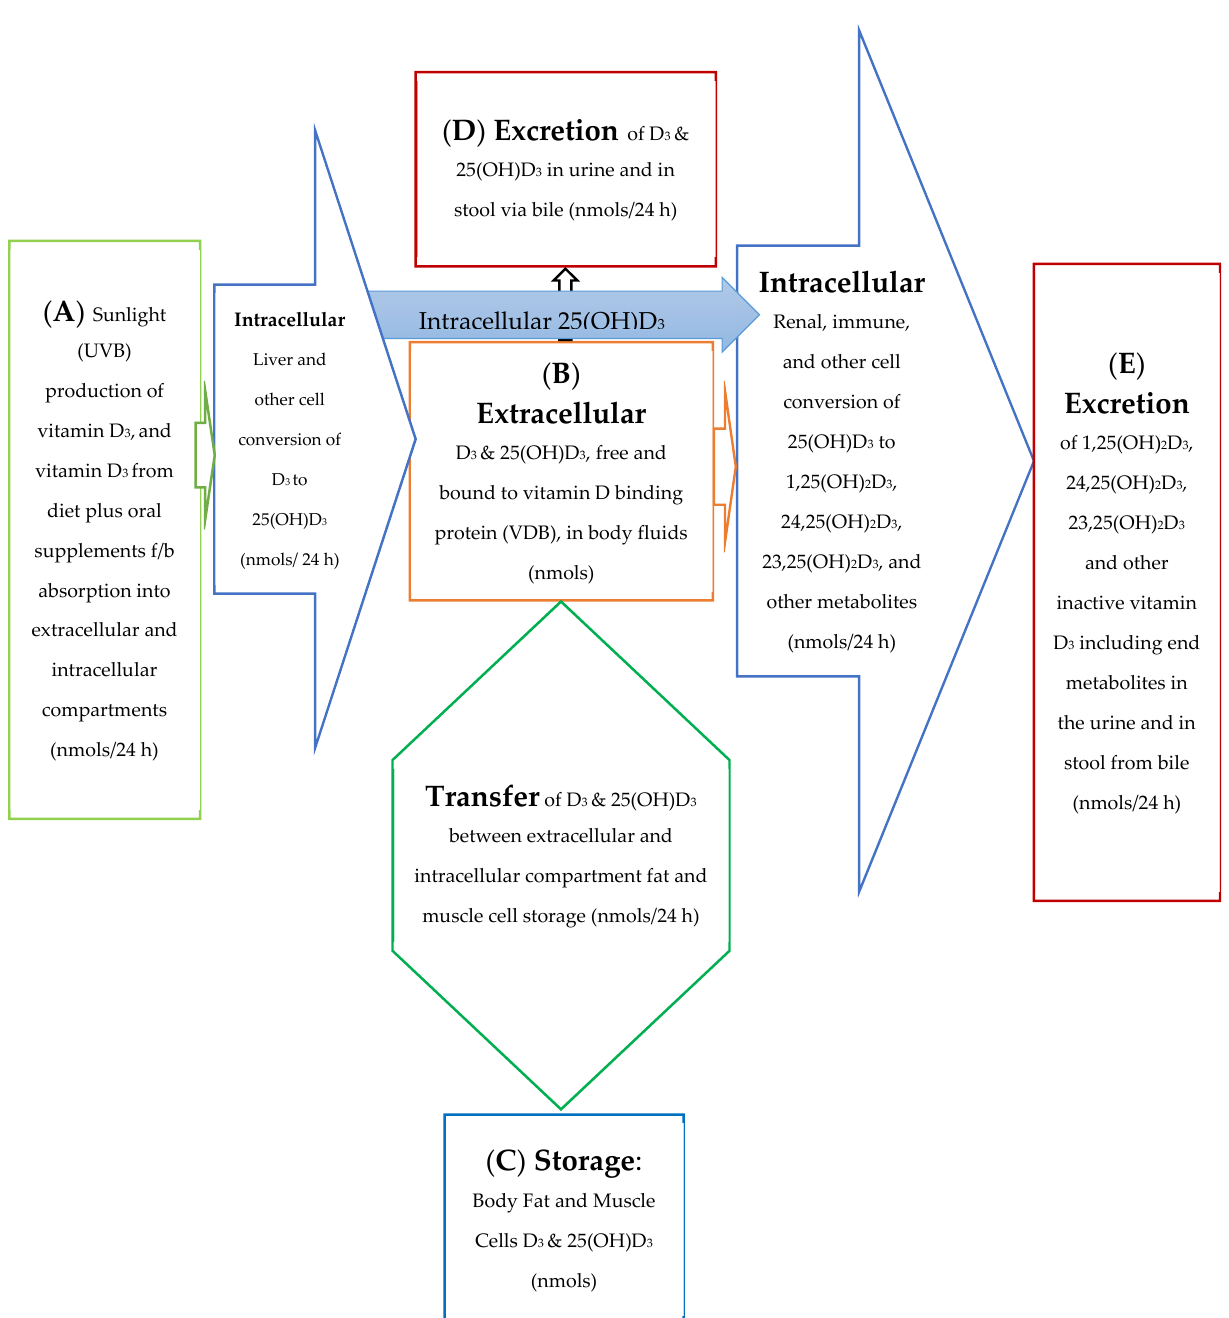
Figure 1. Model for Absorption, Synthesis, Transport, Conversion, Storage, and Excretion of vitamin D Precursors and Metabolites by the Body.